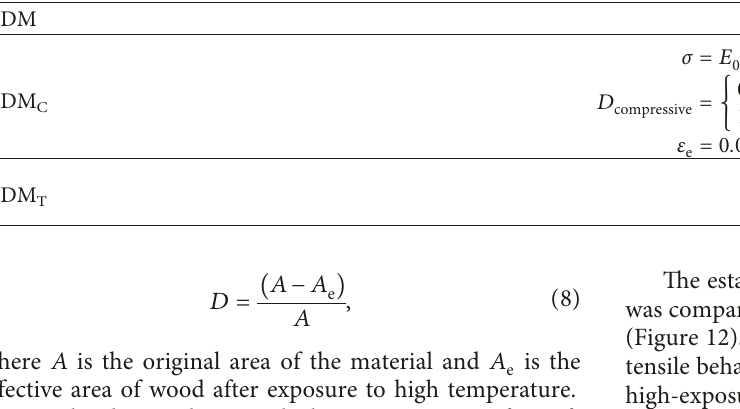
Table 3: CDM of wood at elevated